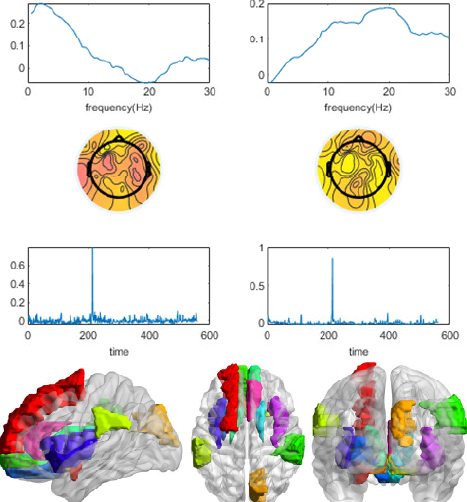
Figure 8. The four indicators of the CMTF model of different numbers of components for subject 16 were calculated. According to the model selection guidelines, a component number of 2 was chosen to analyze the CMTF results for this subject.